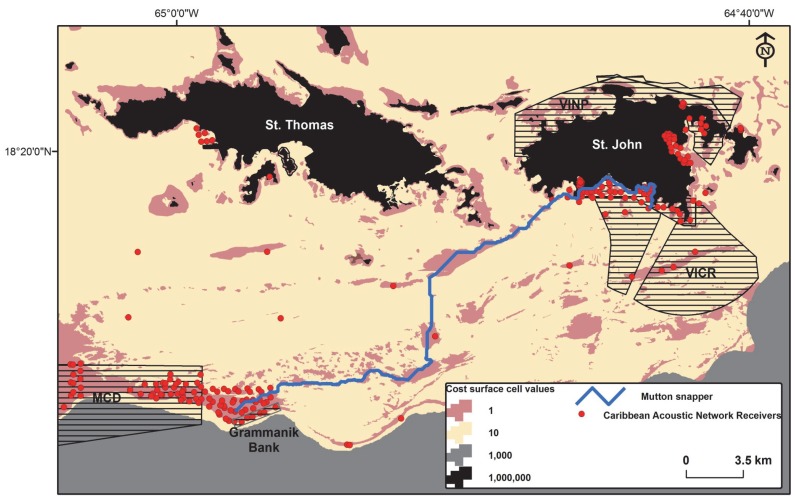
Cost surface for the U.S. Virgin Islands based on relative environmental suitability for shallow-water reef fish.One modeled least-cost path is shown for an individual mutton snapper (Lutjanus analis) that moved a maximum of 40.2 km between two receivers (Virgin Islands National Park [VINP] to shelf edge spawning aggregation). The path was parameterized to preferentially follow wherever possible the low cost coral reef to achieve a minimum accumulative travel cost between the two farthest receivers with detections.